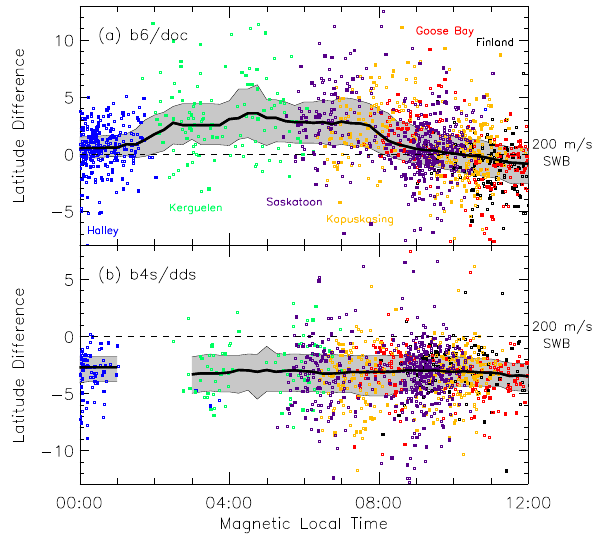
Fig. 5. The full distribution of latitude differences in the morning sector between the 200m/s threshold SWB and ( a ) the b6 and doc PPBs, and ( b ) the b4s and dds PPBs. The difference values are colour-coded according to SuperDARN radar, Halley (blue), Ker- guelen (green), Saskatoon (purple), Kapuskasing (yellow), Goose Bay (red), and Finland (black). The dashed horizontal line at zero difference represents the location of the SWB. The bold line and shaded grey area represent the spatial variation of the median and quartile range, respectively, of the latitude difference